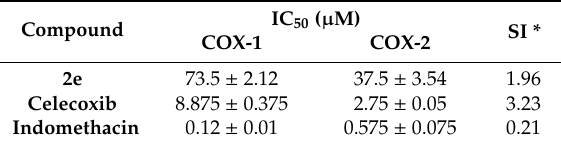
Table 4. The inhibitory e ff ects of compound 2e , celecoxib, and indomethacin on COX-1 and